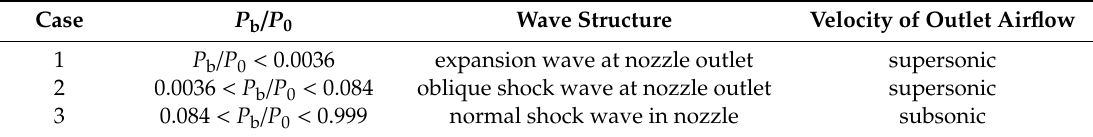
Figure 2. Schematic diagram and structure of the atomizing nozzle. ( a ) Schematic diagram of the atomizing nozzle; ( b ) structure of the atomizing nozzle. Table 1. Different conditions within the atomizing nozzle with different P b / P 0.